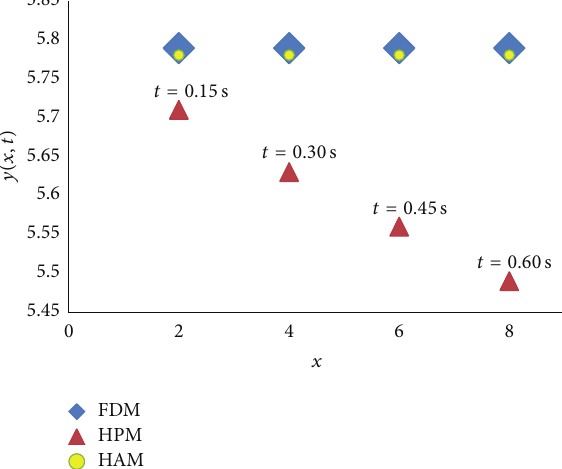
Figure4:ThecomparisonofHPM,HAM,andFDMforthesolution 𝑦(𝑥,𝑡) for different values of 0 ≤ 𝑥 ≥ 8 and 0 ≤ 𝑡 ≥ 0.6 ; ℏ = 0.001